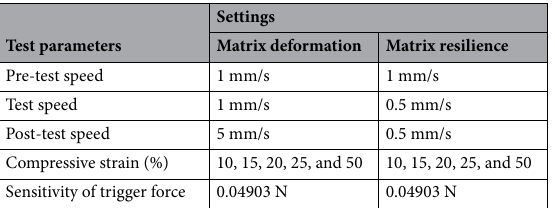
Table 7. Textural parameter settings employed for physicomechanical property analysis of the